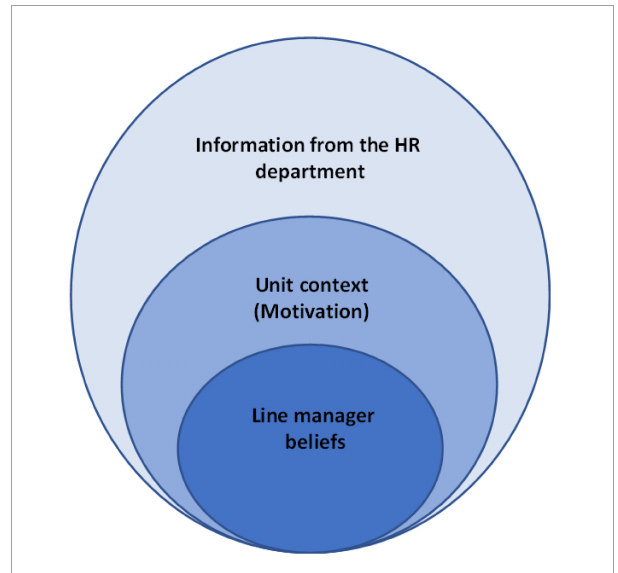
FIGURE1 The relationship between the three key antecedents of HR attributions: Information, beliefs and context.